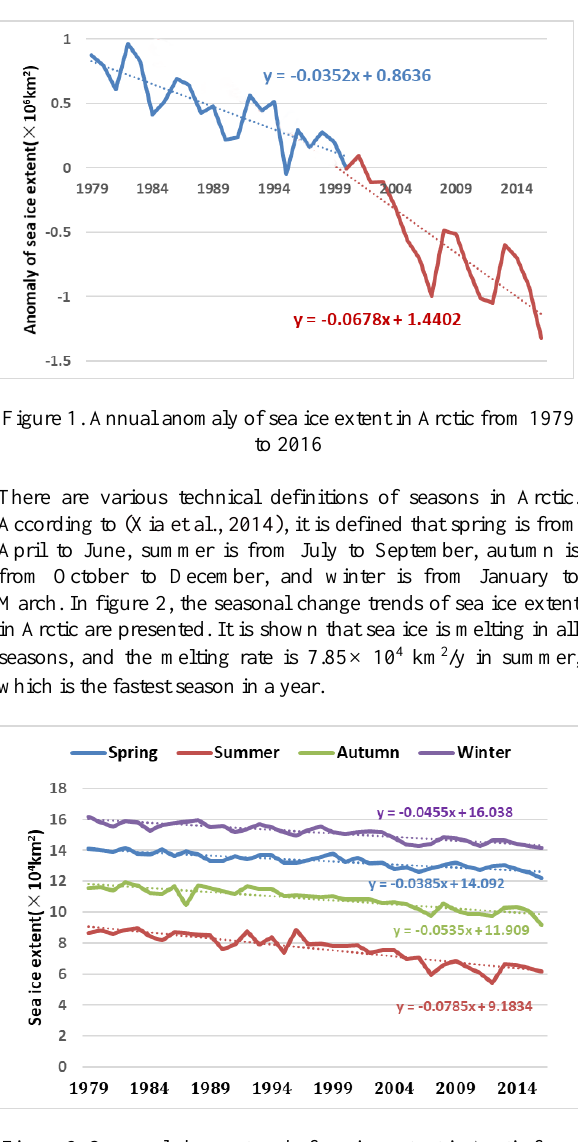
Figure 2. Seasonal change trend of sea ice extent in Arctic from 1979 to 2016 The monthly change trend from 1979 to 2016 is shown in Table 1 and Figure 3. It is shown that the sea ice extent is the largest in March, while smallest in September. On the other hand, the fastest melting rate appears in September, while the slowest melting rate appears in